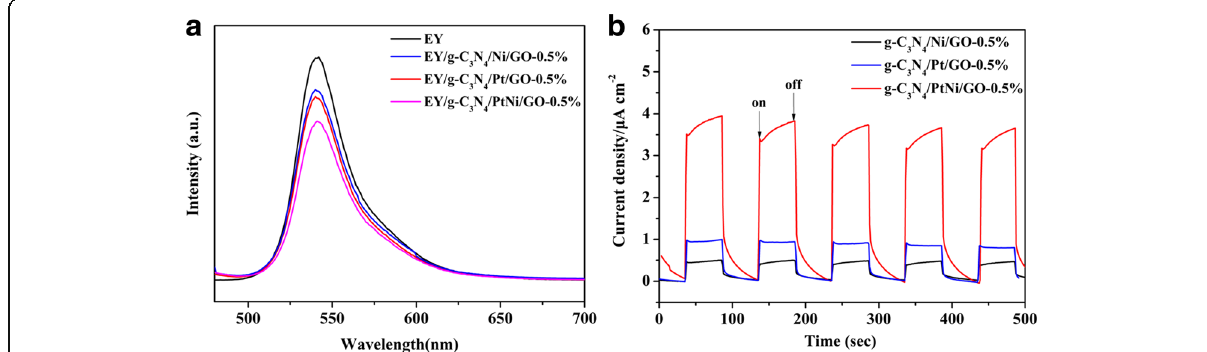
Fig. 8 a The photoluminescence (PL) quenching spectra by g-C 3 N 4 /Ni/GO-0.5%, g-C 3 N 4 /Pt/GO-0.5% and g-C 3 N 4 /PtNi/GO-0.5% samples in 20% (v/v) TEOA aqueous solution (pH = 7). Eosin Y solution: 0.01 mM ( b ) Transient photocurrent responses of g-C 3 N 4 /Ni/GO-0.5%, g-C 3 N 4 /Pt/GO-0.5% and g-C 3 N 4 /PtNi/GO-0.5%